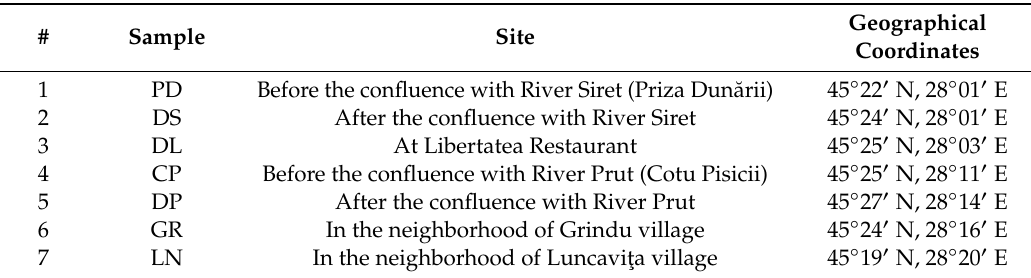
Table 1. Water samples under